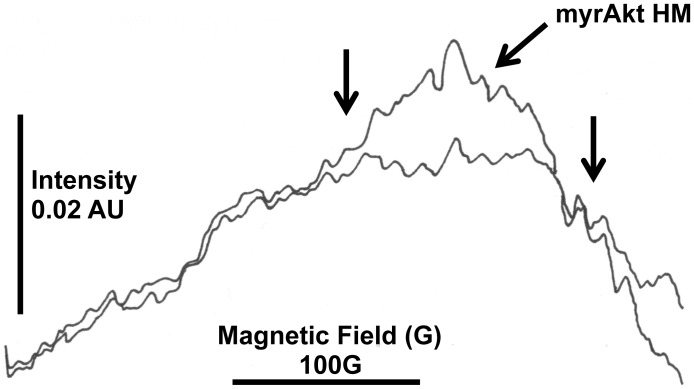
EPR detection of NO indicated marked NOS catalytic activity in midguts from 3 d HM myrAkt An. stephensi relative to 3 d NTG mosquitoes.Whole midguts from 150 NTG and 150 HM An. stephensi at 3-d post-adult emergence were each hand-homogenized in 300 µl of 20 mM HEPES, pH 7.4 with protease inhibitors and phosphatase inhibitors), then incubated for 3 h at 20–22°C following addition of 100 µl reaction buffer (3 mM sodium N-methyl-D-glucamine dithiocarbamate [MGD] complexed with ferrous sulfate prepared fresh), 0.1 mM NADPH, 1 mM calcium chloride and 1 mM L-arginine in degassed 20 mM HEPES, pH 7.4; [104]. After the incubation, 50 to 100 µl of sample was loaded into an EPR tube and measured using a Bruker EPR and XEpr software. Instrument conditions were indicated under Methods. X-band EPR analysis at 190°K of midgut homogenates produced a strong, broad EPR signal with resonance positions (g tensor factors) at g = 2.04 (left arrow) with an associated triplet signal at g = 2.014 with hyperfine splitting of 17.5 Gauss (right arrow). The broad paramagnetic signal at g = 2.04 has been attributed to the trapping of nitric oxide by NMGD-Fe resulting in the formation of NMGD-Fe-NO adduct. The area and/or amplitude of the adduct signal (indicative of concentration of free radicals, in this case NO) was markedly increased in TG midguts.